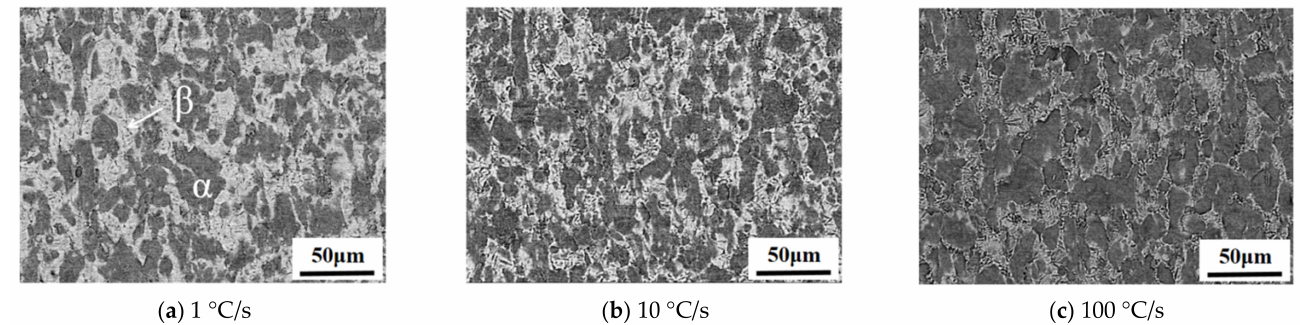
Figure 7. SEM observations of the α and β phases at different forming temperatures and a constant heating rate of 1 ◦ C/s.